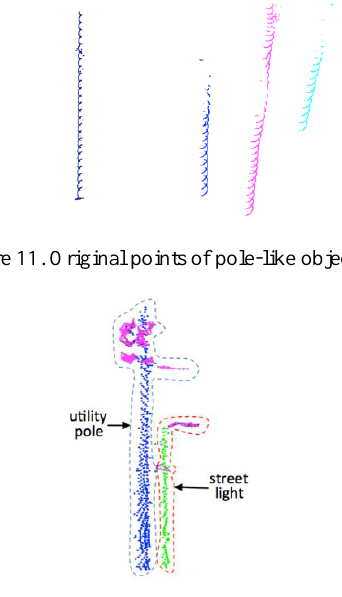
Figure 12. Grouping neighbor additional components